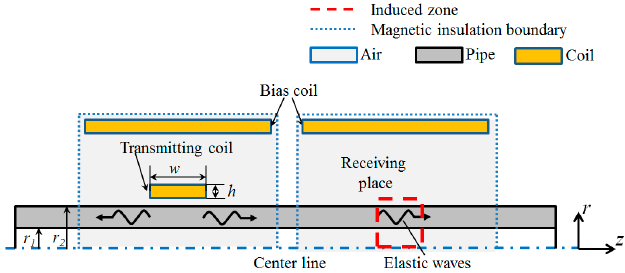
Figure 2. Schematic diagram of the FE model for generating and receiving guided waves based on the magnetostrictive effect.